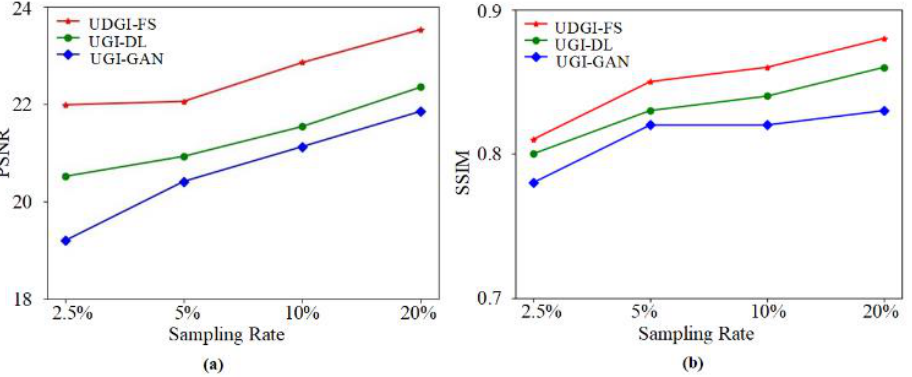
Figure 11. The PSNRs and SSIMs of the reconstructed fish images of UDGI-FS, UGI-DL, and UGI- GAN at different sampling rates. ( a ) PSNRs of the reconstructed fish images of UDGI-FS, UGI-DL, and UGI-GAN at different sampling rates; ( b ) SSIMs of the reconstructed fish images of UDGI-FS, UGI-DL, and UGI-GAN at different sampling rates.